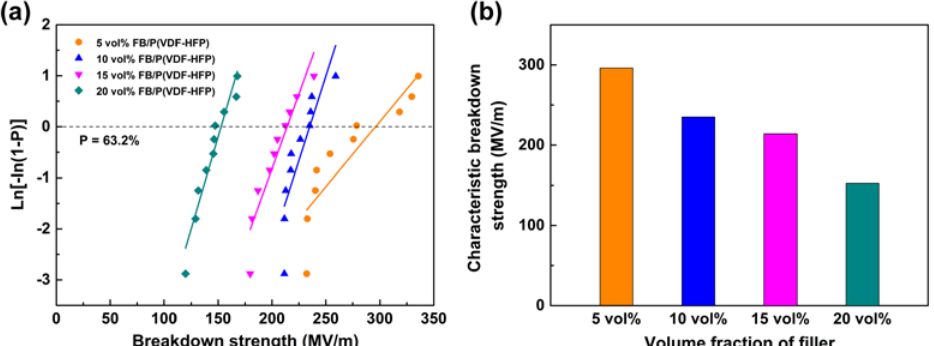
Figure 9. ( a ) Weibull distribution for breakdown strength and ( b ) characteristic breakdown strength of composites.